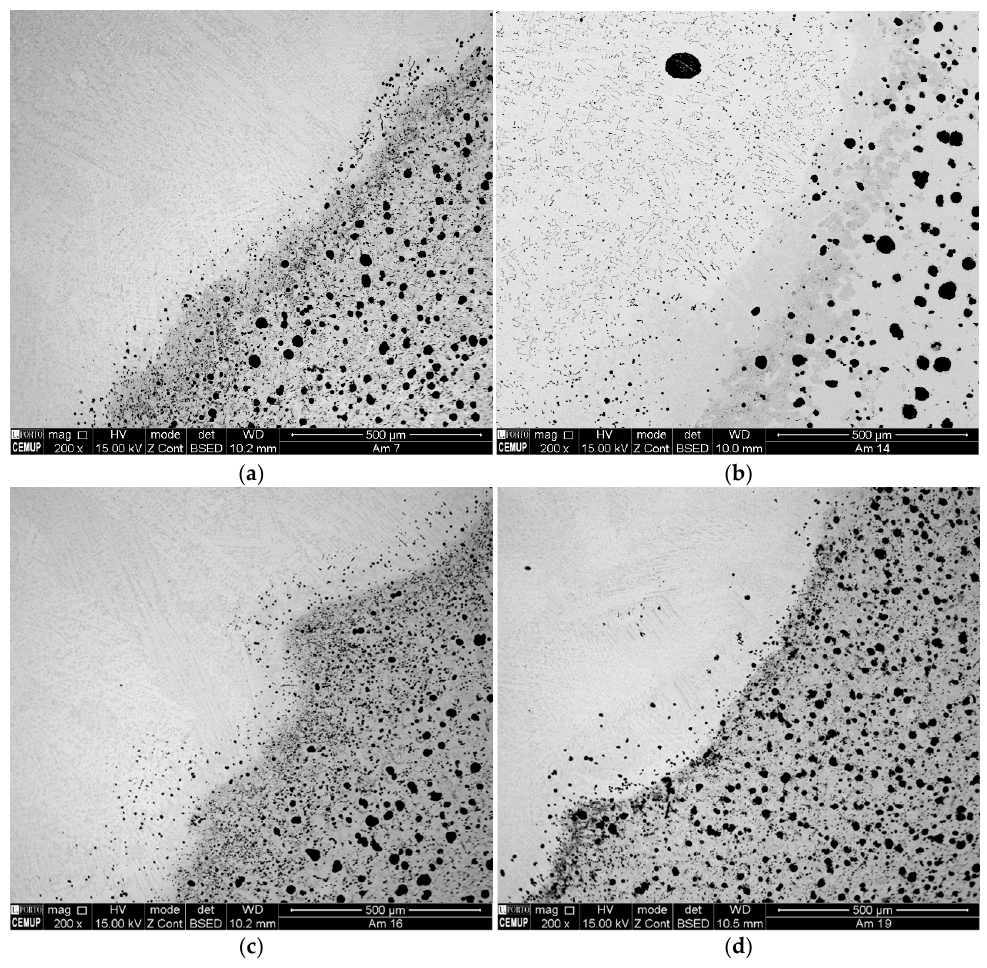
Figure 2. SEM microscopic analysis at 200× magnification with a 4% Nital etching; ( a )